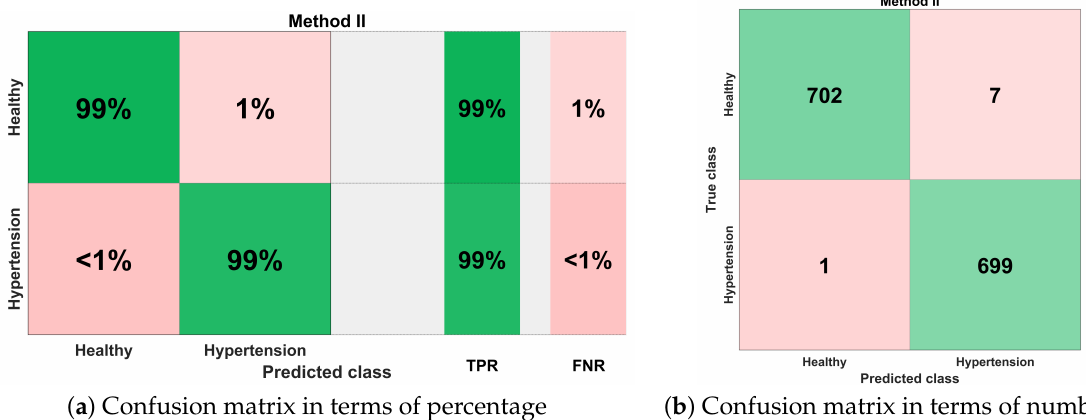
Figure 18. Confusion matrix for method II.